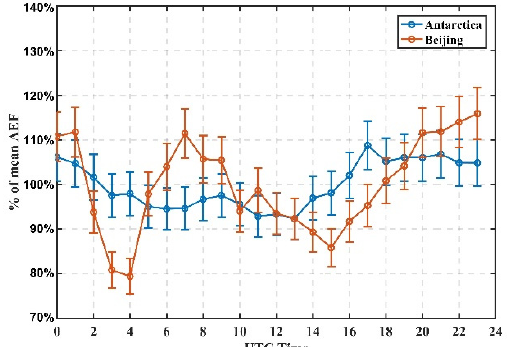
Figure 5. Results of the atmospheric electric field daily variation comparison between the Antarctic Chinese Zhongshan Station and Beijing Thirteen Hill Station. The vertical coordinate is the percentage of atmospheric electric field/mean atmospheric electric field, and the horizontal coordinate indicates UT. The red curve represents the percentage curve of daily variation at the Antarctica Chinese Zhongshan Station, while the blue line represents the percentage curve of daily variation at the Beijing Thirteen Hill Station. Error bars represent the corresponding standard deviations.